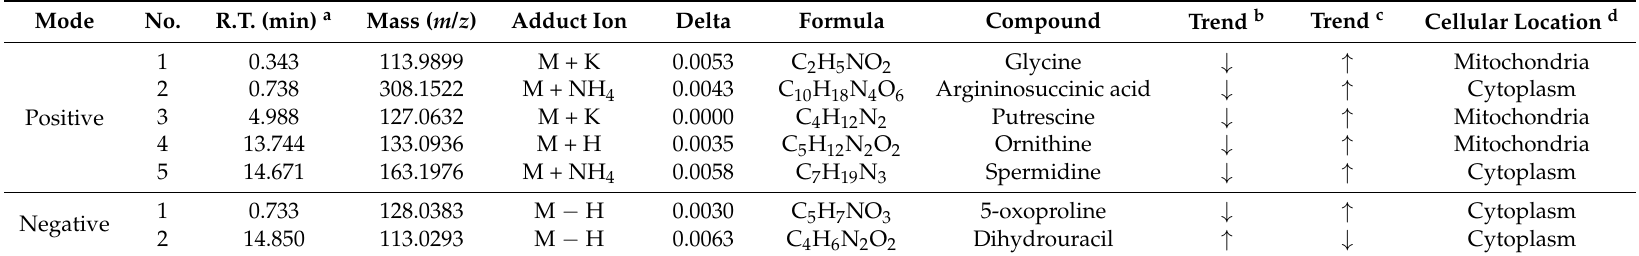
Table 3. Potential biomarkers and their cellular